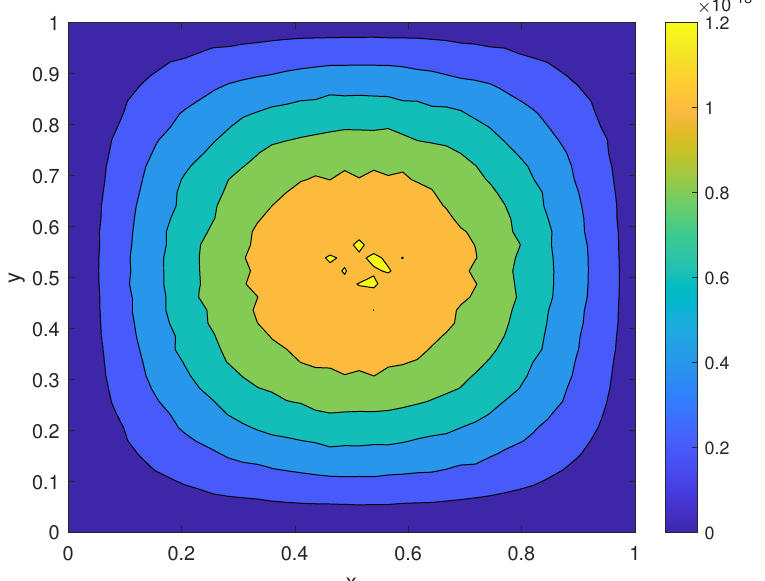
Figure 4. Contours of pointwise error for Case 4 at the final time t = 1 with α = 0.2, N = 4000, K =